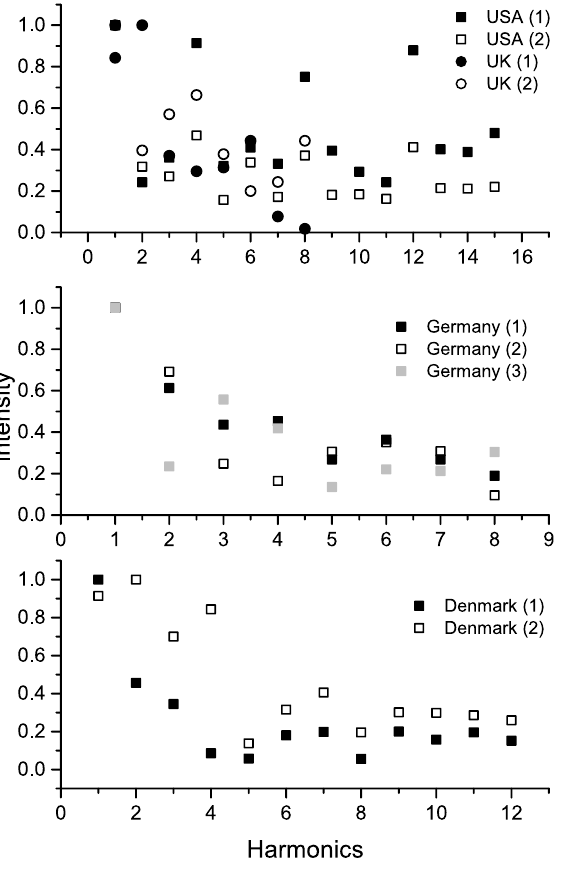
Fig. 2. The amplitudes of Fourier spectra for countries and parties presented in Fig. 1. The description of symbols is the same as in the earlier ¯gure. The spectra are normalized in the way that the highest amplitude corresponds to